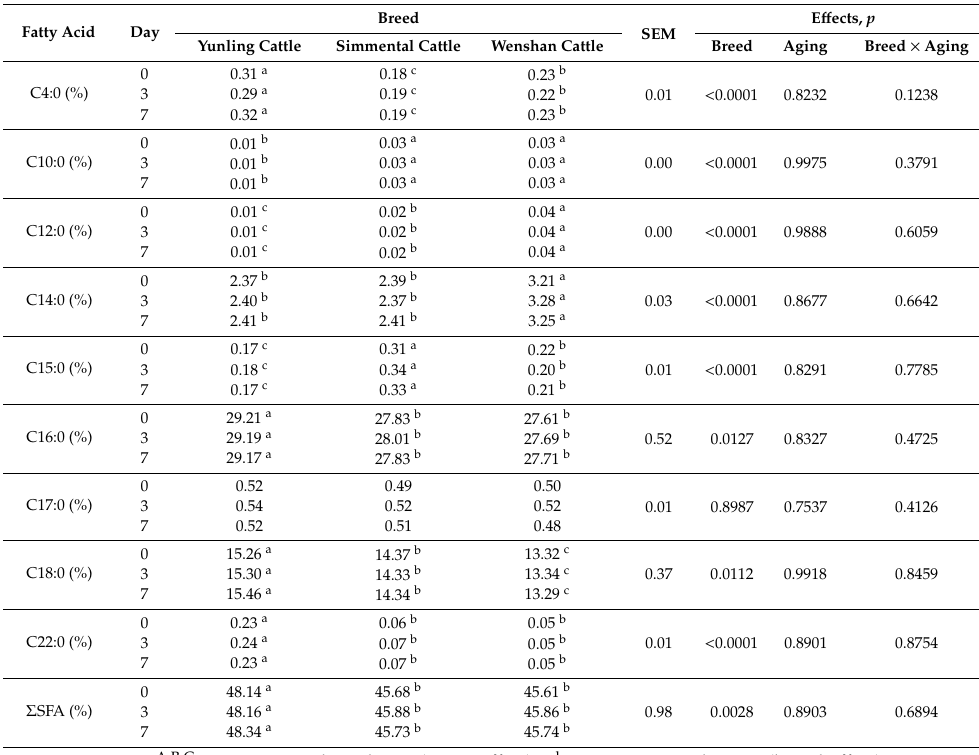
Table 7. The saturated fatty acids content a ff ected by breed and aging.